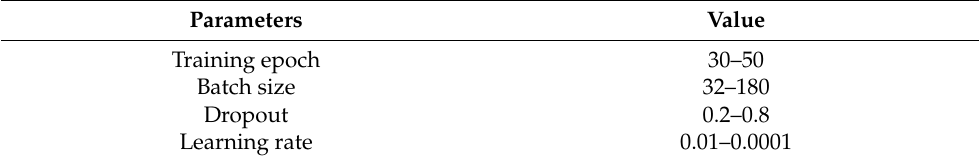
Table 7. Parameters used in CNN for training.